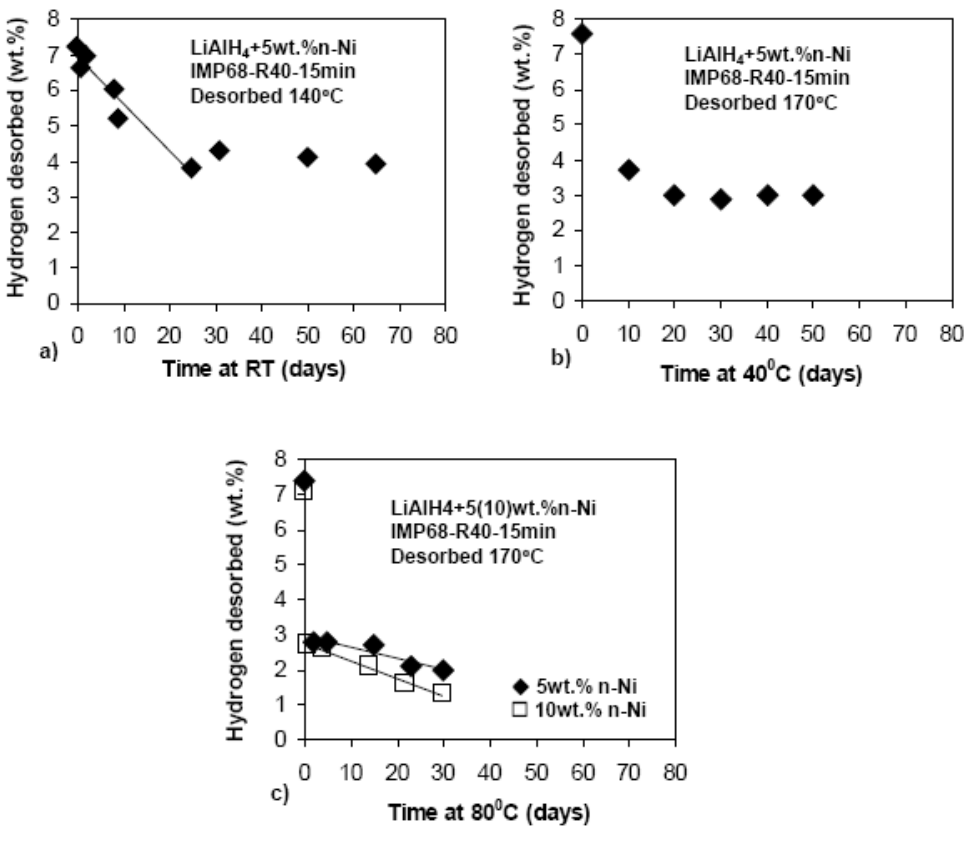
Figure 14. Plots of hydrogen desorbed vs. storage time in days (1 day = 24h) for LiAlH + 5(10) wt.% n-Ni mixtures ball milled for 15 min under high energy mode. 4